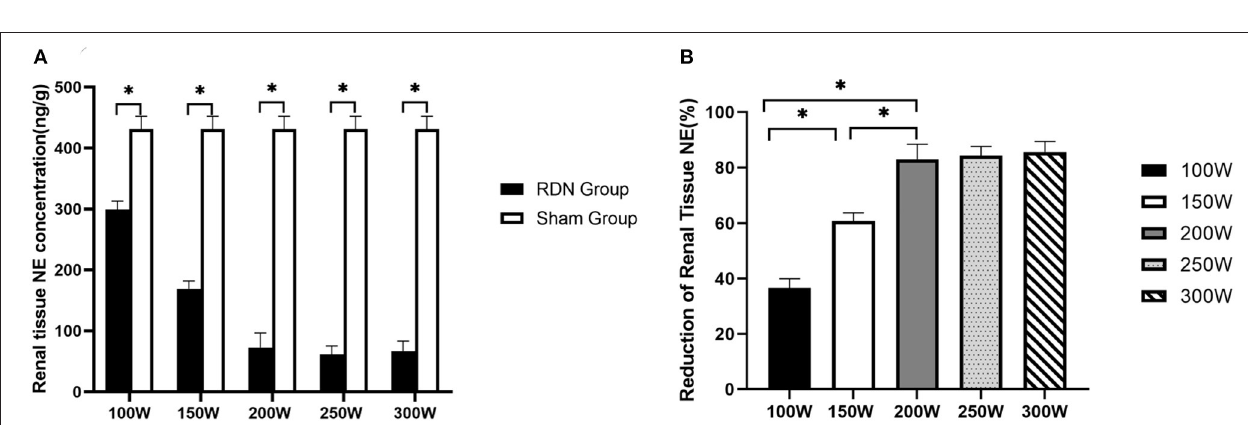
FIGURE 3 | Renal tissue NE concentration at day 28. (A) Comparison of mean renal tissue NE concentration between RDN groups and sham control group at day 28. (B) Reduction in renal tissue NE in RDN groups at day 28. NE, norepinephrine. * < 0.05.